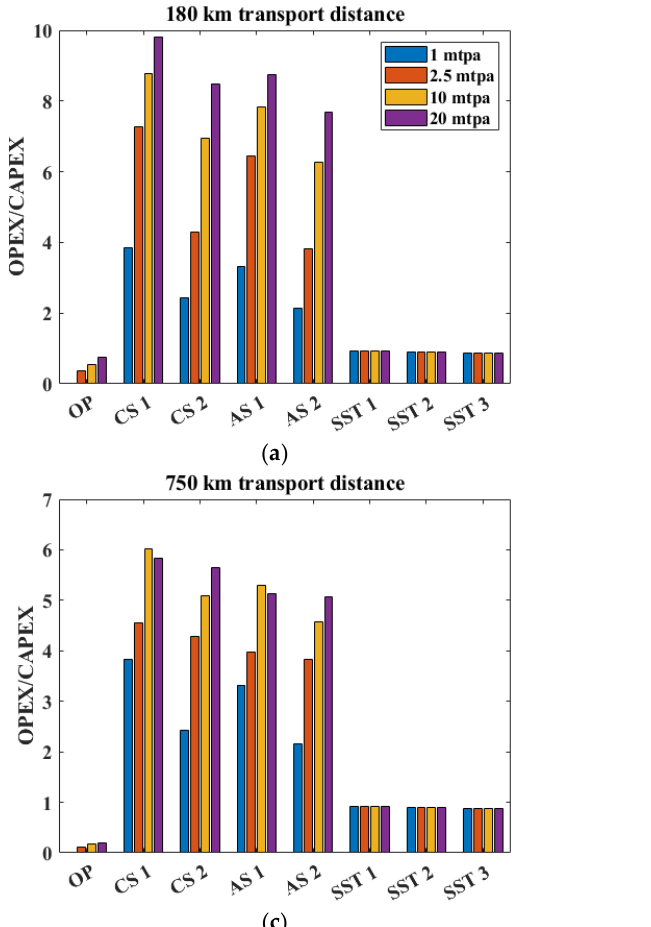
Figure 9. CAPEX estimations.